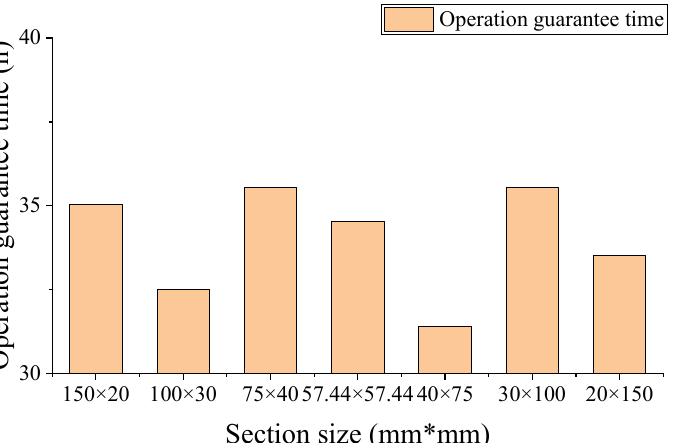
Figure 16. Effect of the geometric size of phase change heat storage module on the outlet temperature of the reservoir.